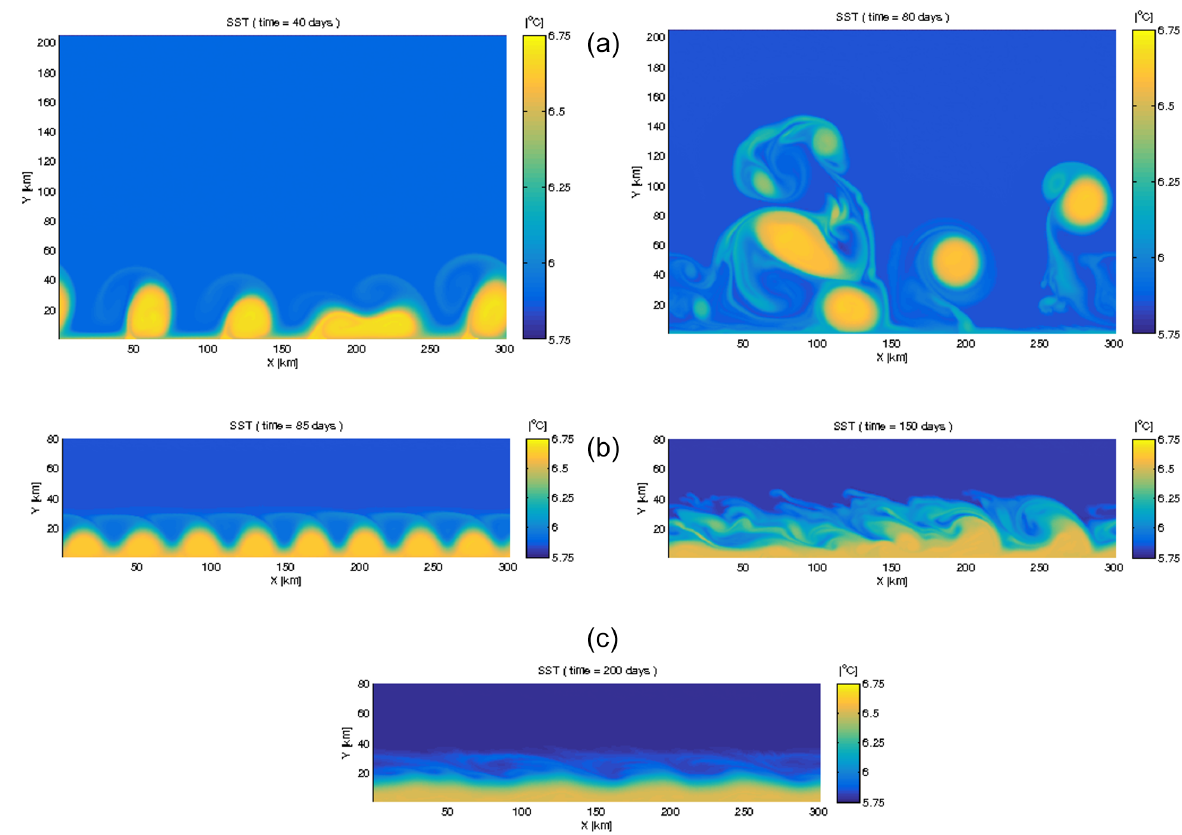
Figure 10. Snapshots of SST for the coastal eddies regime (a) , the coastal meanders regime (b) , and the quasi-stable along-shore current regime (c) . The details of these simulations are presented in Table 2. Table 2. Same as Table 1, but for the high-resolution cases (600m grid resolution). s